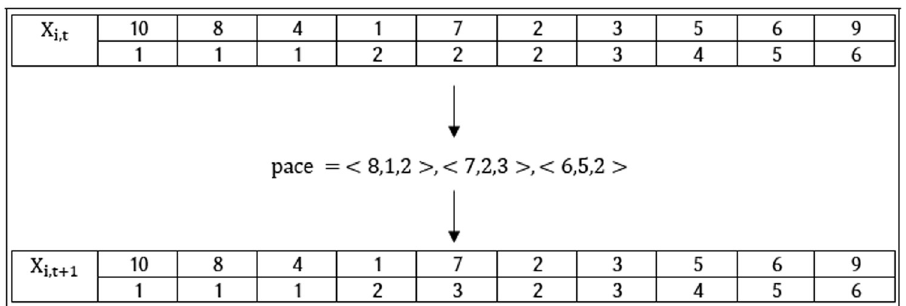
Figure 5: An example of updating a solution with The pseudocode for this algorithm can be seen in Algorithm 1.